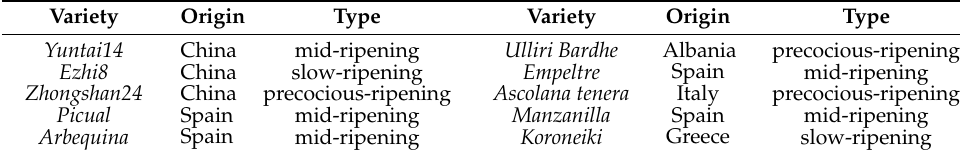
Table 1. The information on olive varieties planted in